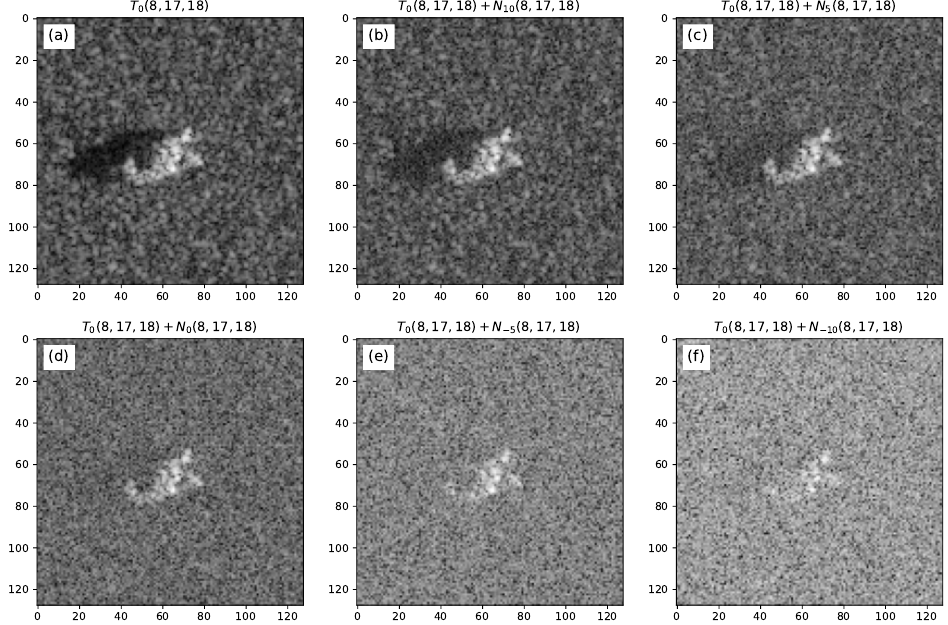
Figure 16. ( a ) Measured data chip of a T-72 tank— T 0 ( 8,17,18 ) . Gaussian noise added relative to